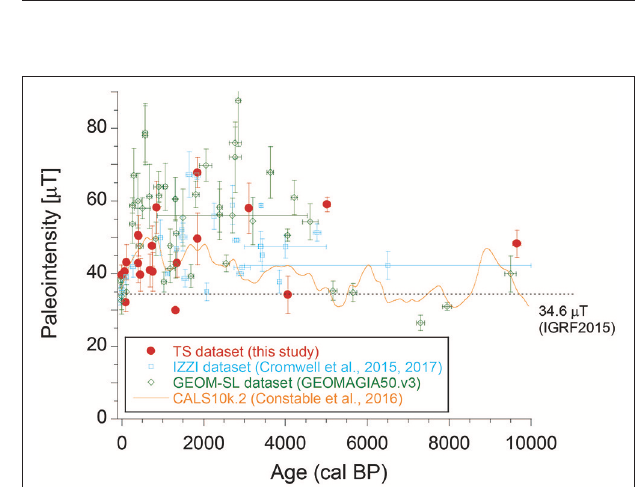
FIGURE 6 | Comparison of the site-mean paleointensities determined by the Coe–Thellier method (Tanaka and Kono, 1991; Mankinen and Champion, 1993; Pressling et al., 2006) and the Tsunakawa–Shaw method (this study). Error bars indicate one standard deviation. Dashed lines indicate gradients of 10% high (red), equivalent (black), and 10% low (blue).